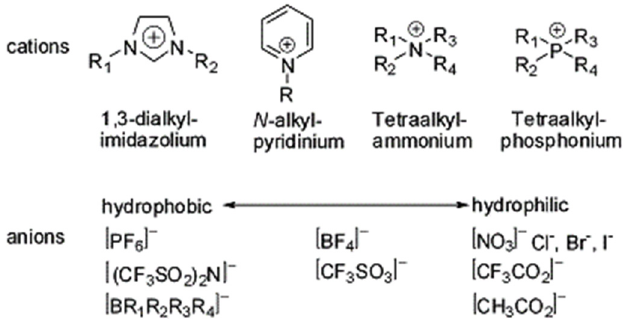
Figure 2. Commonly investigated cations and anions of ILs. Reprinted 2011 from [64] with permission from the